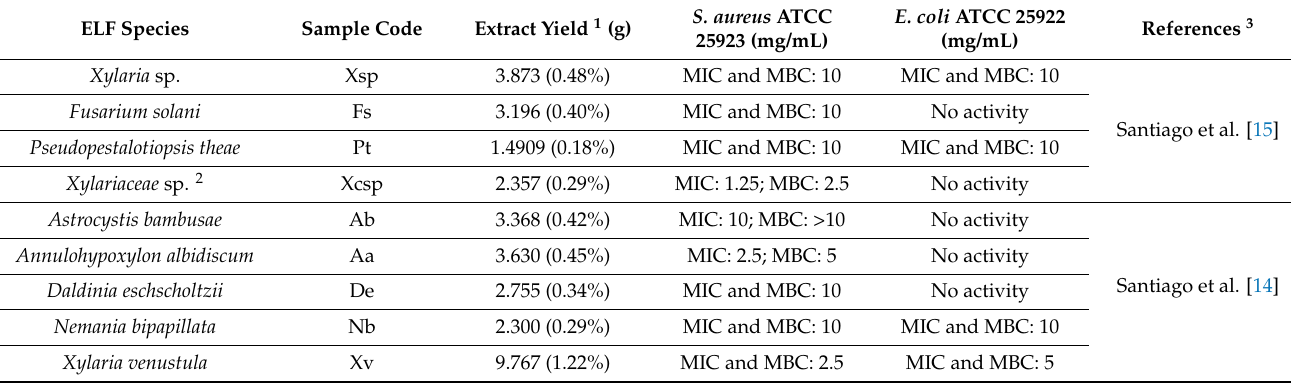
Table 2. Minimum inhibitory concentration (MIC) and minimum bactericidal concentration (MBC) values of the nine ELF crude extracts against S. aureus and E. coli . ELF Species Sample Code Extract Yield 1